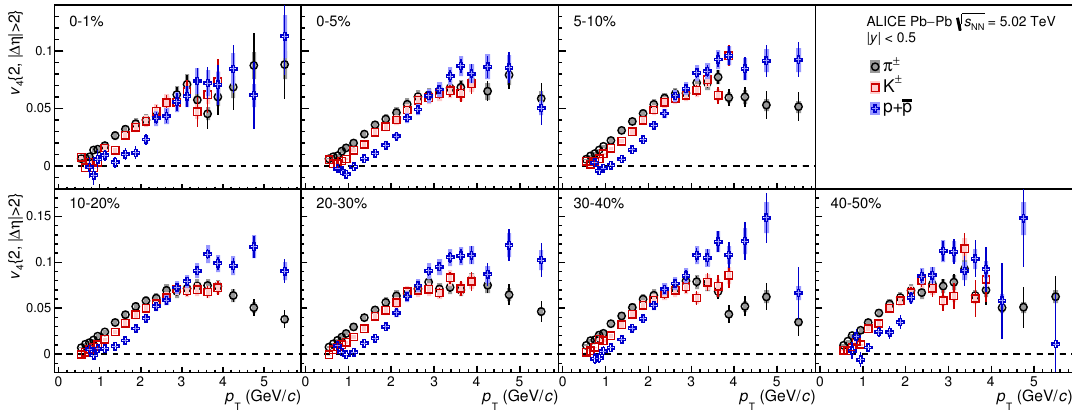
Figure 7 . (Colour online) The p T -di(cid:11)erential v 3 of (cid:25) (cid:6) , K (cid:6) , p+p, (cid:3)+(cid:3), and K 0 centrality classes. Statistical and systematic uncertainties are shown as bars and boxes, respectively.